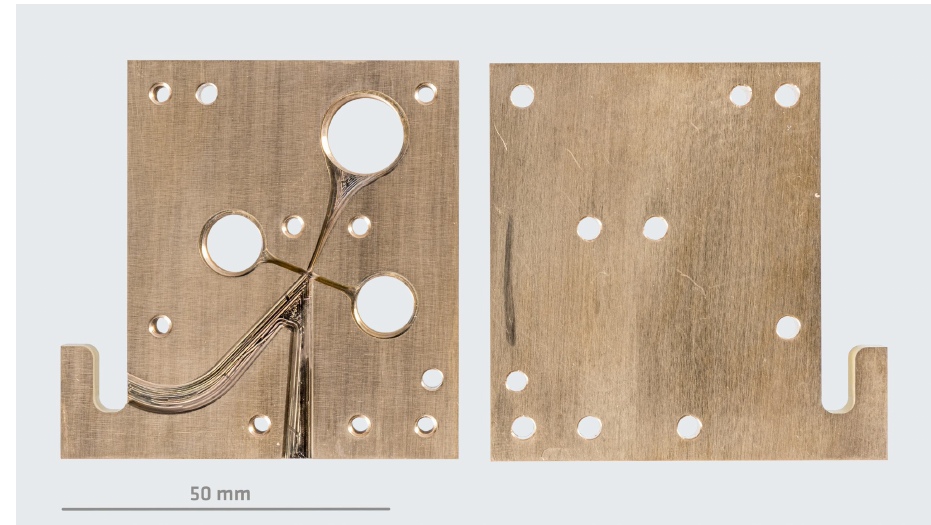
Figure 2. Initial protoype of the fluidic transducer made from brass. Figure 3 on the left shows a time series that was obtained with the measurement microphone Microtech Gefell MV301 in combination with a MV302 pre-amplifier about 20 mm from the outlet and the resulting spectrum. The coloured sections in the left plot mark the different states of the fluidic transducer and the corresponding spectra are shown in the right plot. The switching action of the device, signified by the pink area, produces a strong pulse of about 138 dB with a broadband ultrasonic spectrum between 30 kHz and 80 kHz.